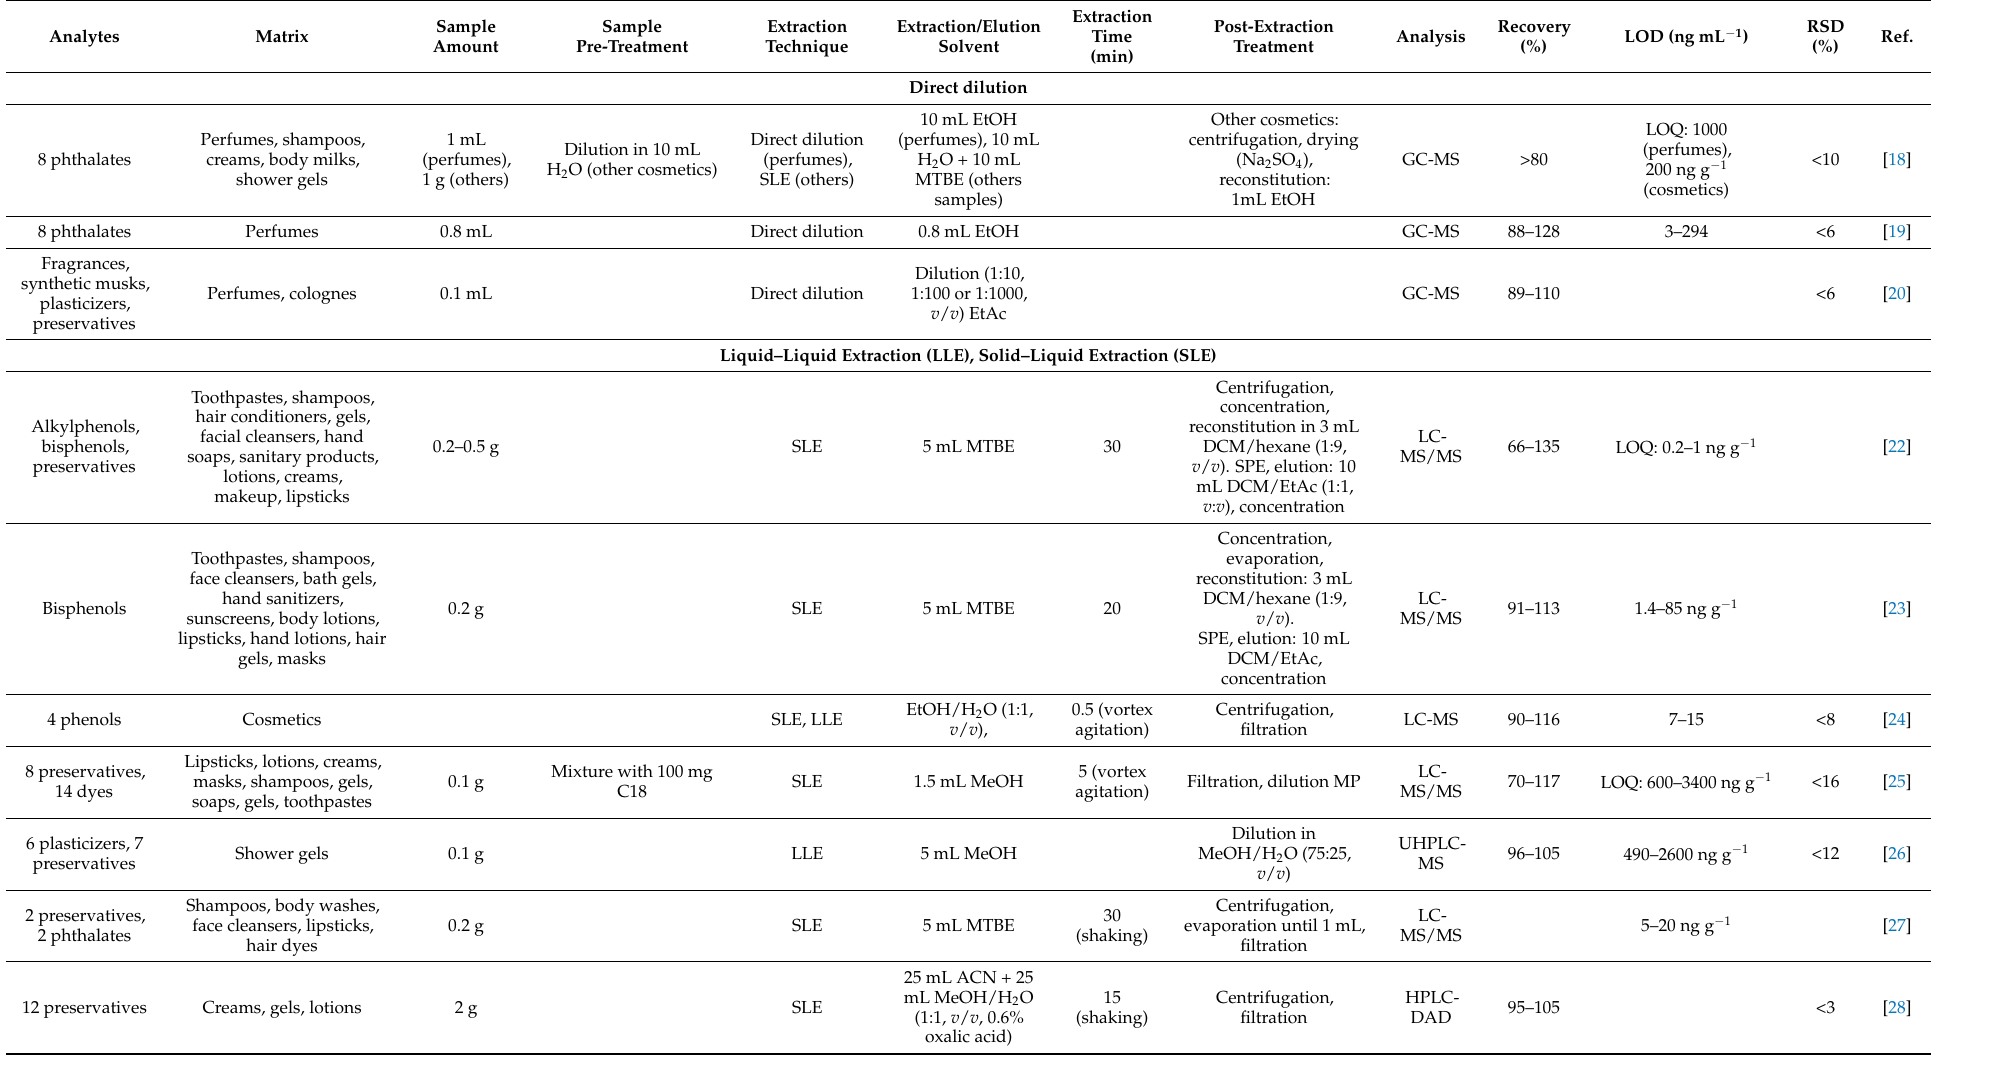
Table 1. Classical and advanced sample preparation strategies for cosmetics analysis: direct dilution, LLE, SLE, UAE, SPE, PLE and,